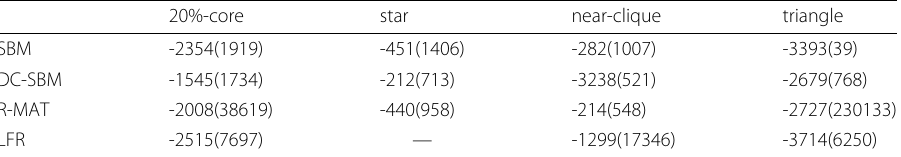
Table 4 Average best log-likelihood for 50 trials of generating hyperbolic communities with SBM, DC-SBM, R-MAT, and LFR, with standard deviations 20%-core star near-clique triangle SBM -2354(1919) -451(1406) -282(1007) -3393(39) DC-SBM -1545(1734) -212(713) -3238(521) -2679(768) R-MAT -2008(38619) -440(958) -214(548) -2727(230133) LFR -2515(7697) — -1299(17346)